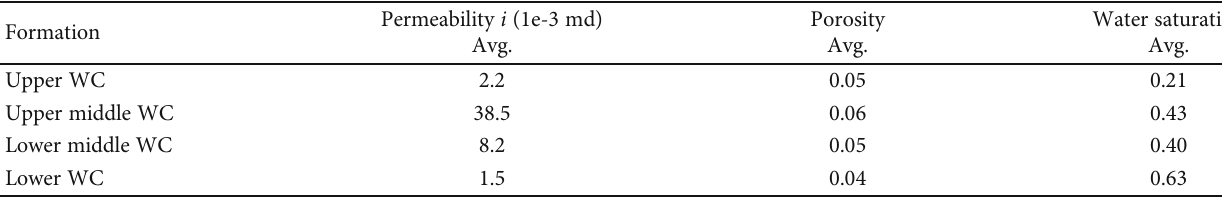
Table 2: The average values for properties in di ff erent formations.